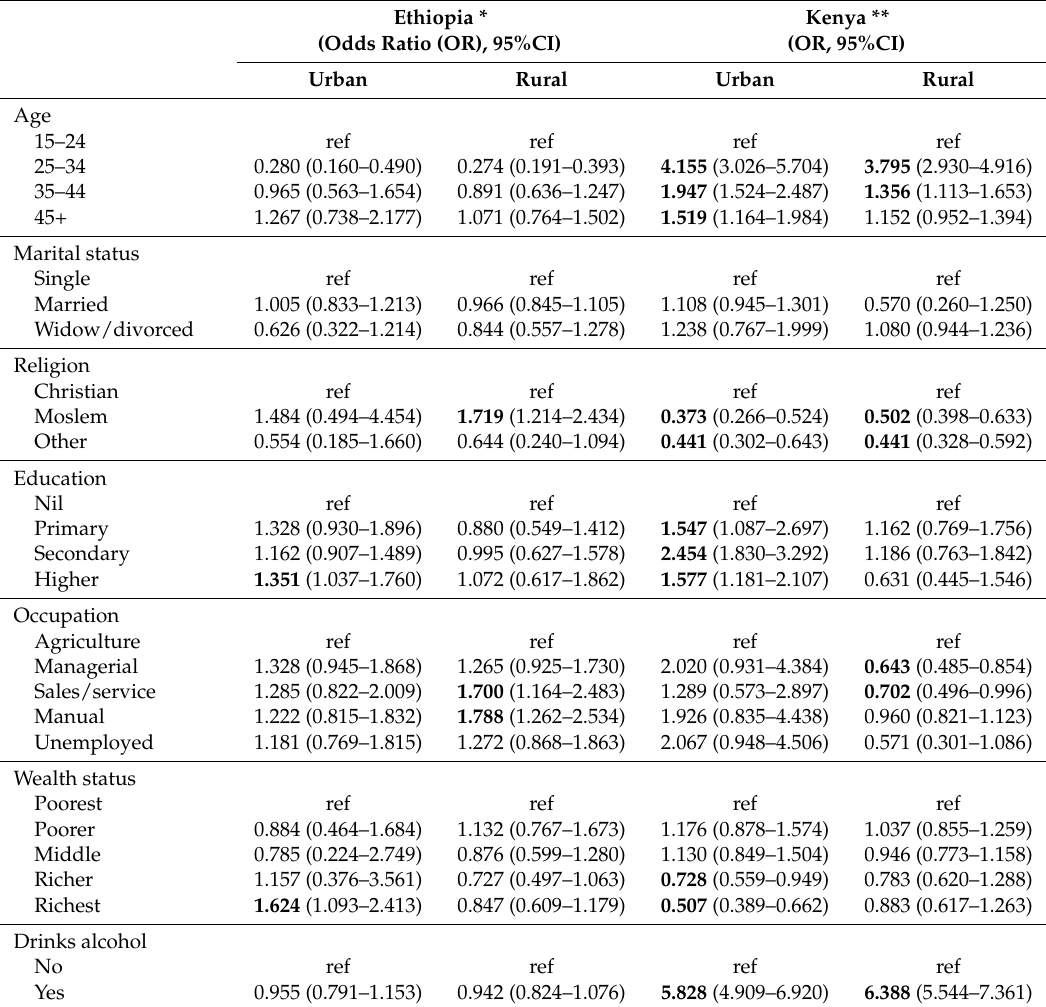
Table 5. Association between smoking and sociodemographic